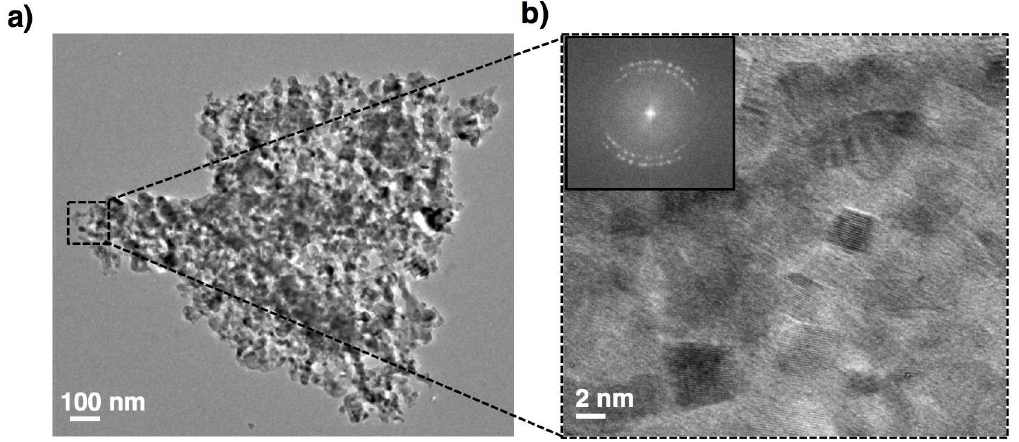
Fig 2. TEM images of plant derived pSi. a ) low magnificationimage of free standing pSi microparticle, b ) high resolutionTEM image with a small silicon crystalline domains in the range of 4–8 nm, inset shows